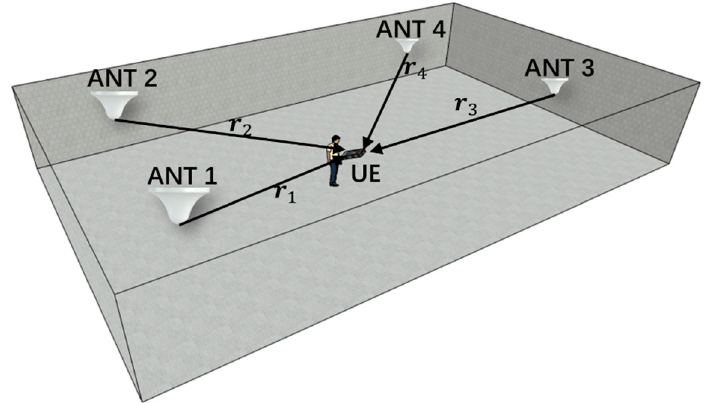
Figure 1. The system model of user equipment (UE) indoor positioning based on the indoor distribution system.